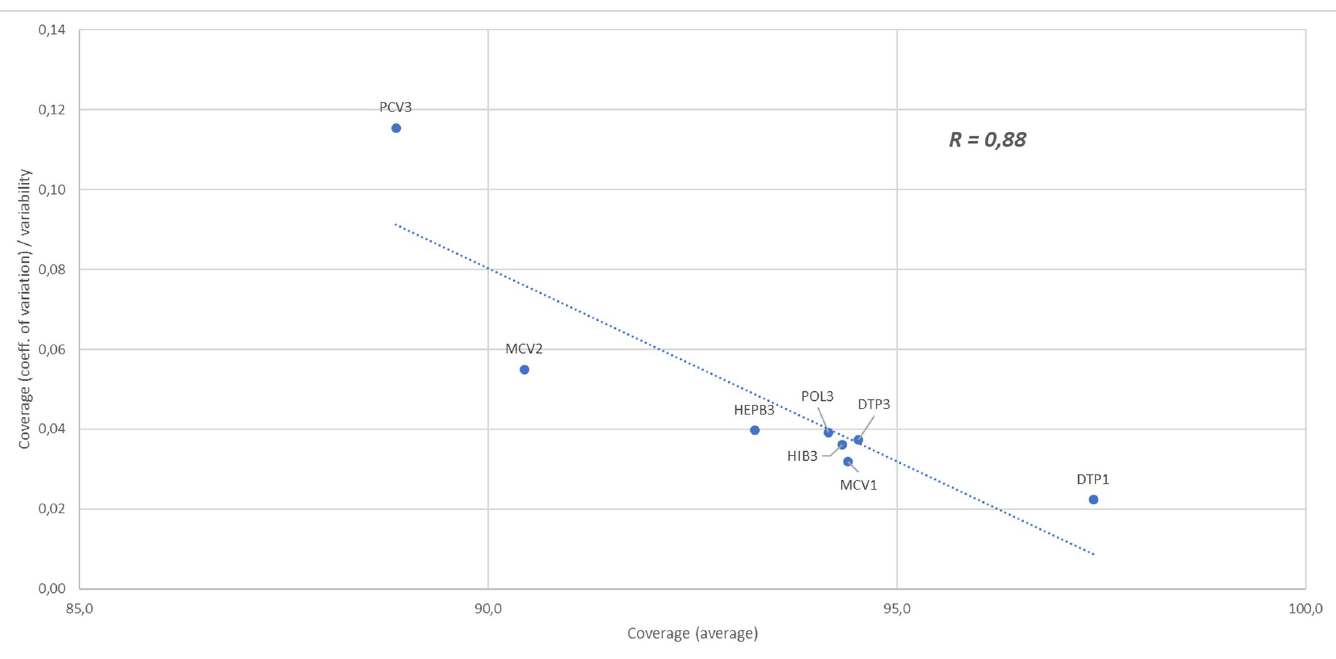
Fig 2. Scatterplot diagram reporting the correlation between the average vaccination coverage and the vaccination coverage variability computed at vaccine level (i.e. inter-vaccine analysis).